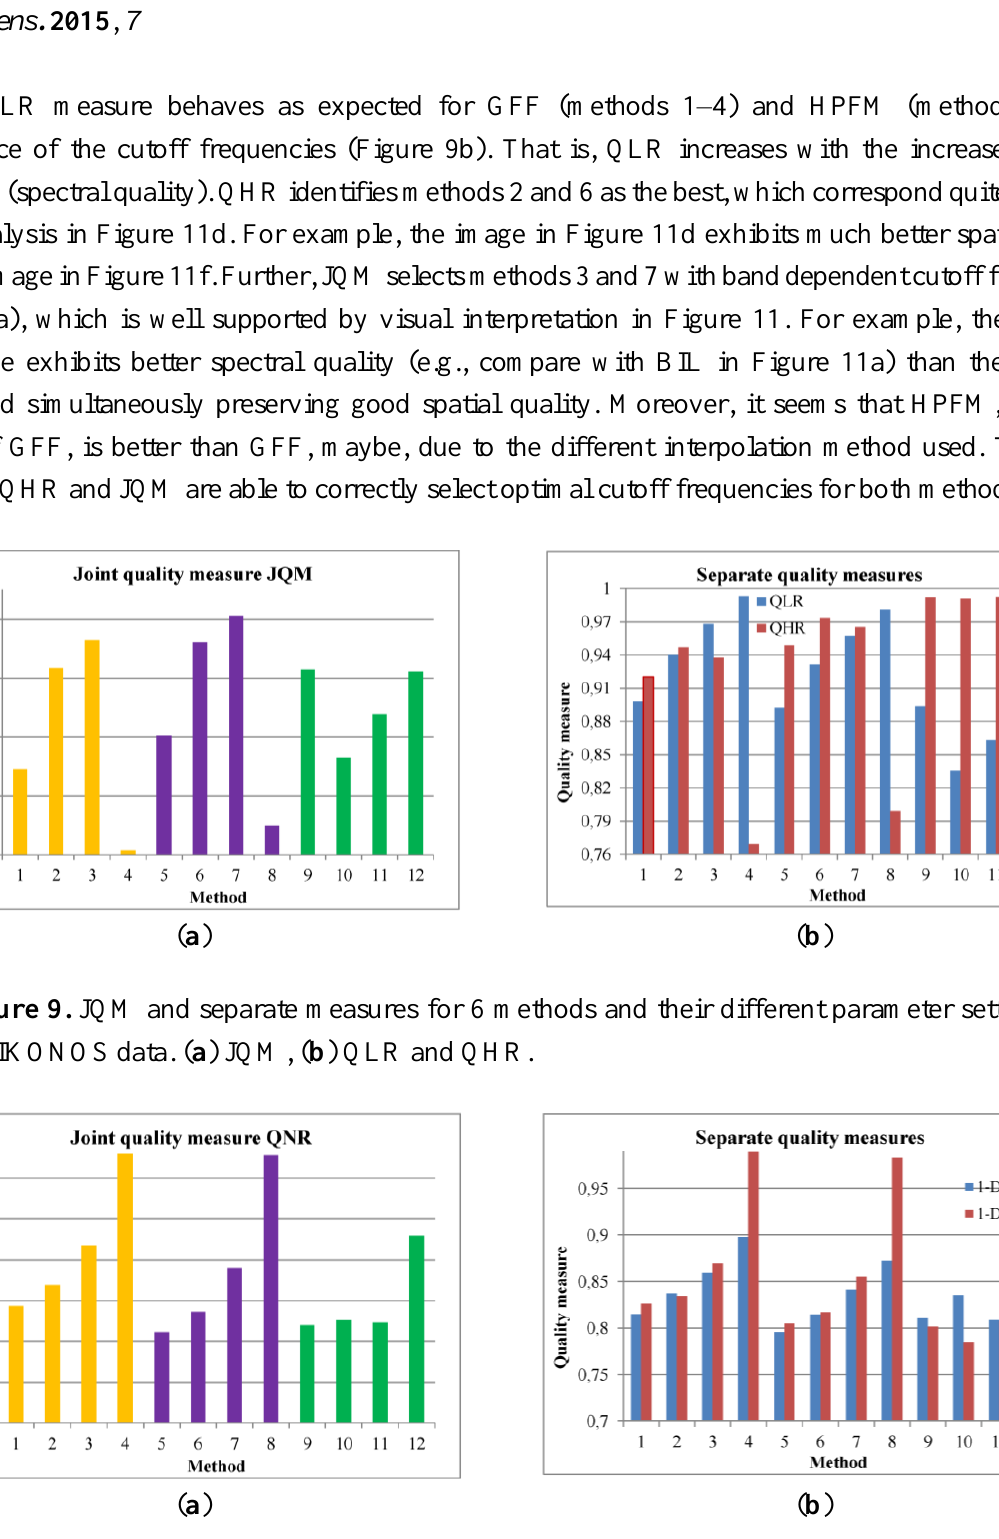
Figure 10. QNR and separate measures for 6 methods and their different parameter settings for IKONOS data. ( a ) QNR, ( b ) 1− DL and 1− DS